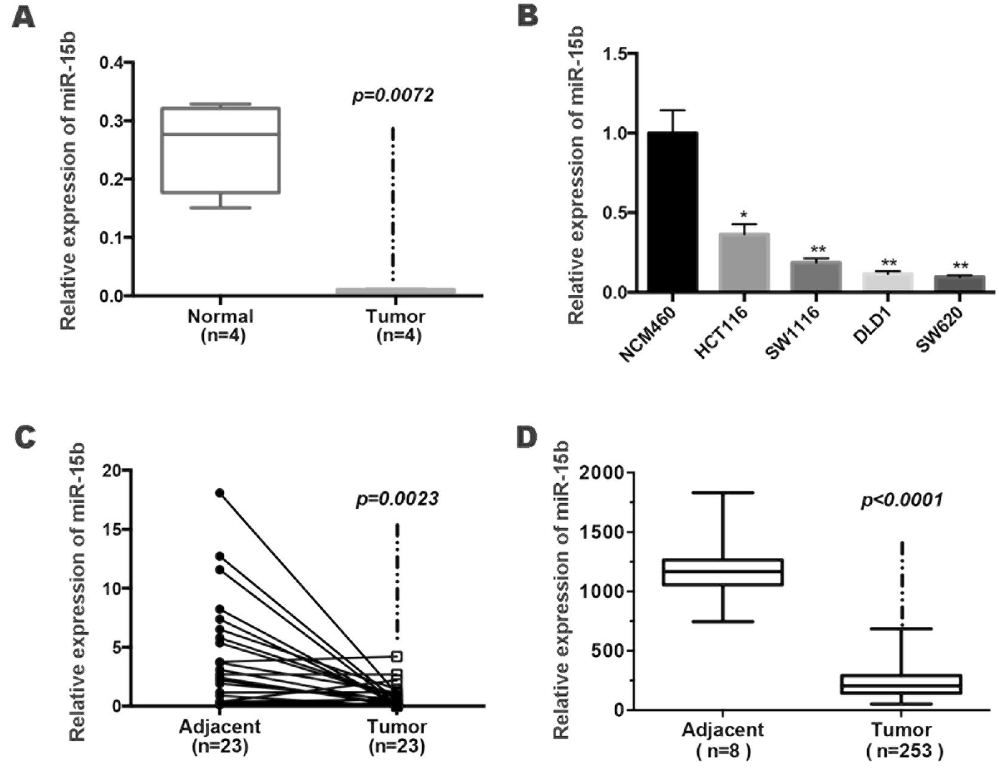
Figure 1. miR-15b-5p was downregulated in CRC. ( A ) Real-time PCR confirmation of miRNA microarray results was performed in four paired tumor and normal tissues in CAC mice. ( B ) Determination of miR- 15b-5p expression levels in four colon cell lines and NCM460 cells ( * p < 0.05, ** p < 0.01, *** p < 0.001). ( C ) Downregulation of miR-15b-5p in primary colorectal cancer tissue compared to the adjacent normal tissue (paired Student’s t -test). ( D ) miR-15b-5p expression levels decreased significantly in primary colorectal cancer tissue compared to normal tissue via the TCGA